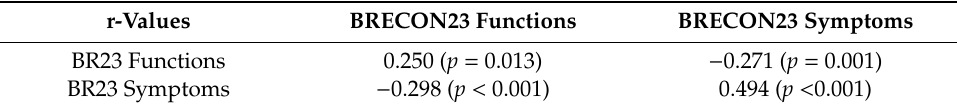
Table 5. Correlations between BRECON23 and